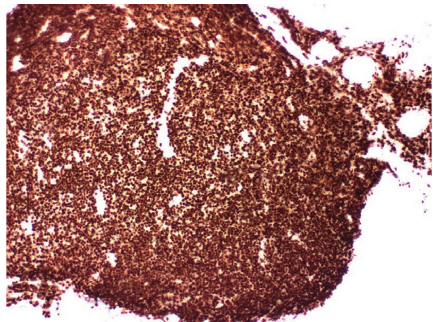
Figure 3: Lymphoid aggregate positive for PAX5 stain.